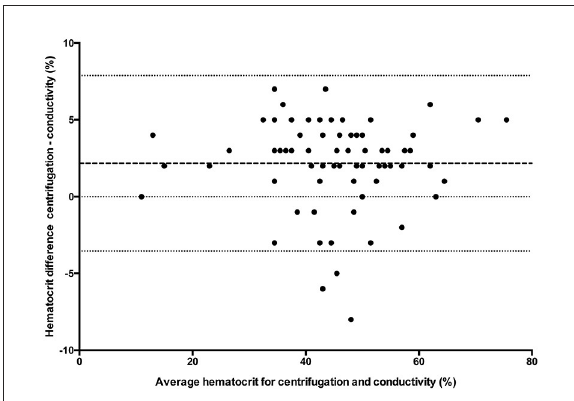
FIGURE2 Comparison of mean bias (bolder dotted line) and 95% limit of agreement (outer dotted lines) between the centrifuged hematocrit value and optical